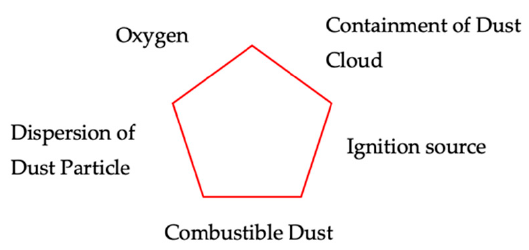
Figure 7. The dust explosion pentagon, redrawn from [71].